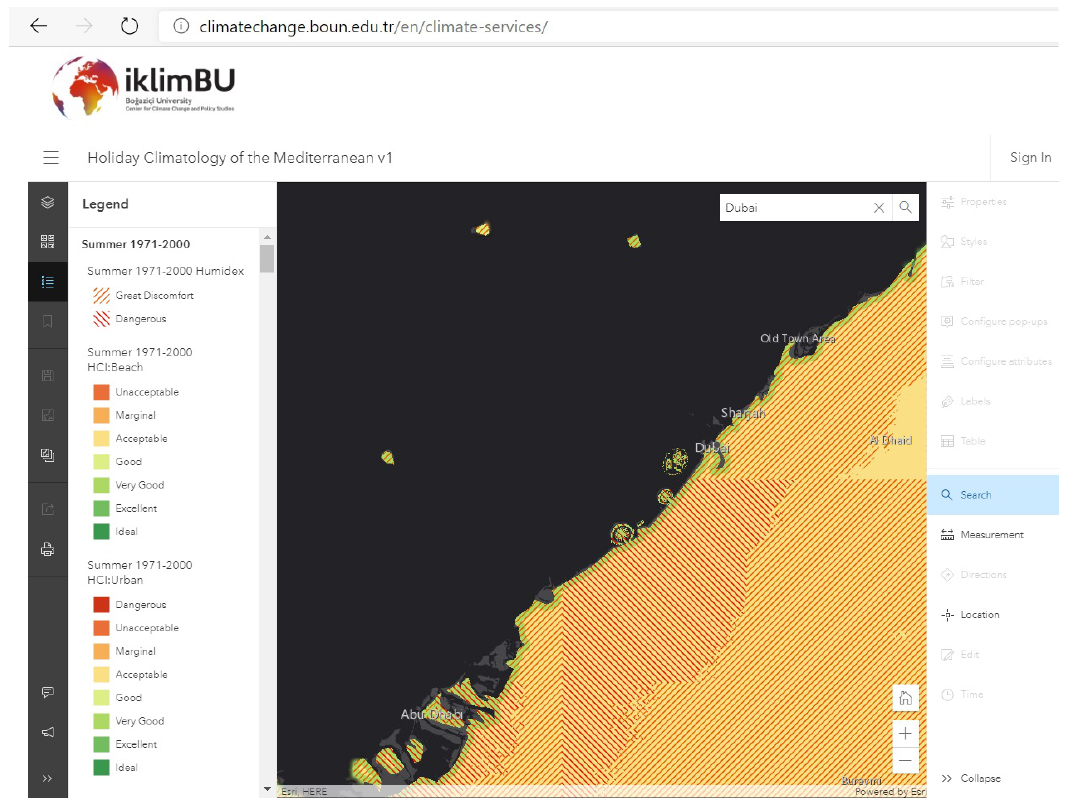
Figure 7. A snapshot of the climate service—Holiday Climatology of the